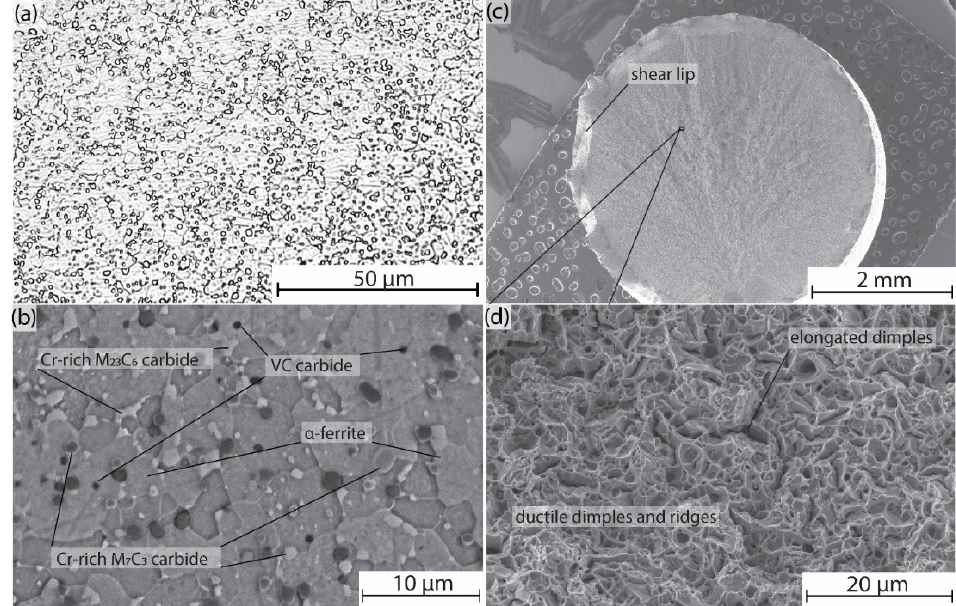
Figure 7. ( a ) Reflected light image of the As-Received sample. Background is featureless α -ferrite. ( b ) Backscatter electron image highlighting α -ferrite, mixed carbides, and bright white Cr-rich M 23 C 6 carbides along grain boundaries. ( c ) Wide-field secondary image of the fracture surface highlighting a shear lip. ( d ) Small-scale secondary electron image with ductile dimples and ridges showing ductile mode of failure.